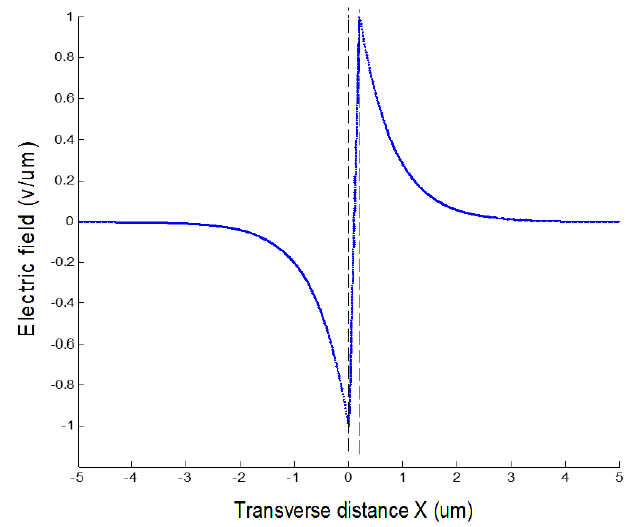
Figure 13. The electric field distribution at α c, s = 0 with d f = 0.198 μ m.